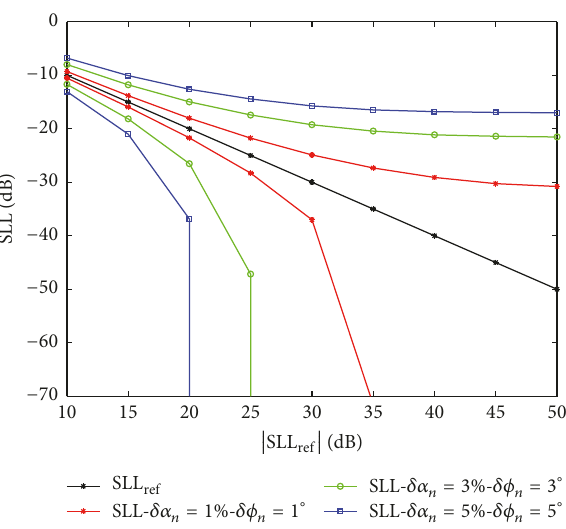
Figure 4: SLL interval based on IA against ISLL ref